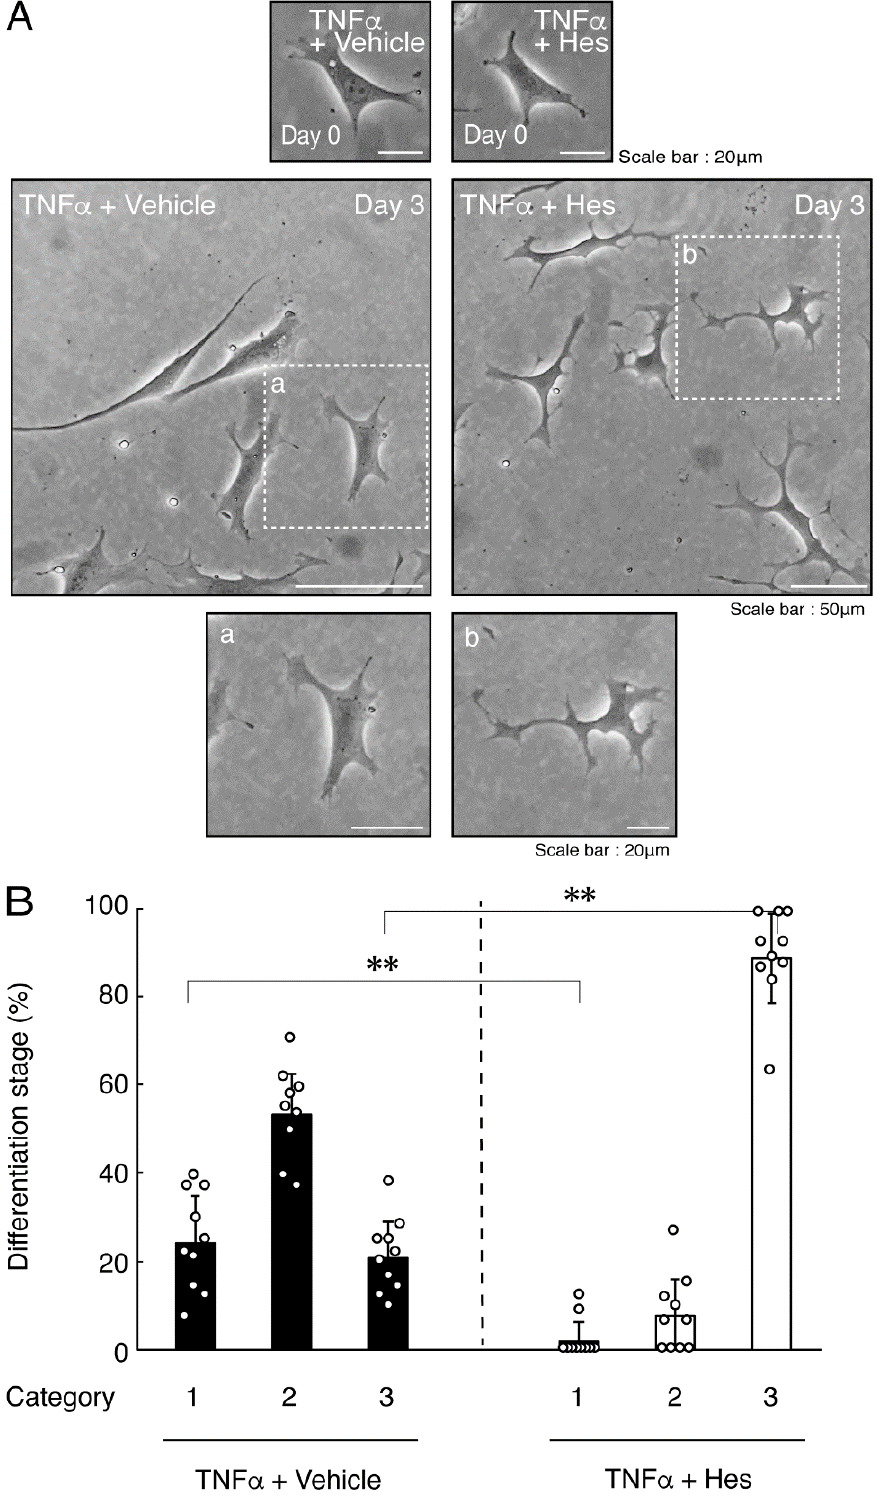
Figure 6. Hesperetin recovers TNF α inhibition of oligodendroglial cell morphological differentiation. ( A , B ) Differentiation of FBD-102b cells treated with TNF α was induced in the presence of hesperetin (Hes) or control vehicles. Lower panels a and b are magnified dotted squares a and b of middle panels. Differentiation efficiencies were divided into 3 categories and depicted in graphs (**, p < 0.01; n = 10 [taking one picture each from 10 independent experiments]).